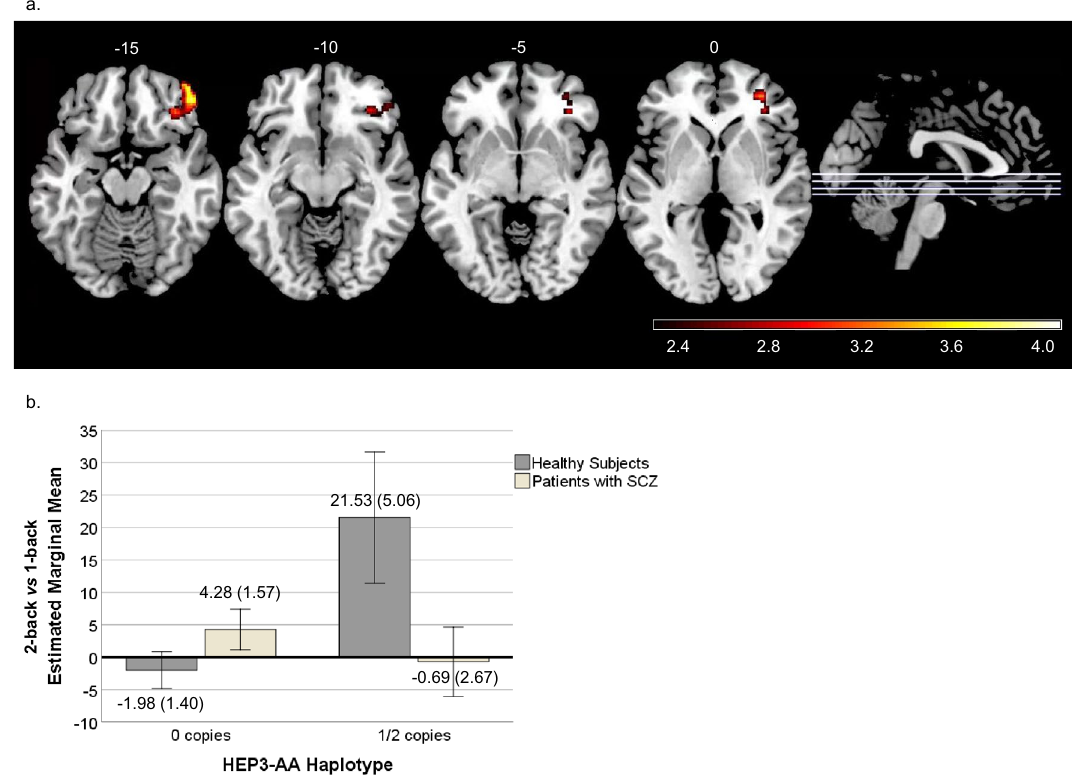
Figure 3. ( a ) Brain regions showing the axial view of the cluster with significant diagnosis × HEP3-AA interaction in 2-back vs 1-back contrast. The right side of the image represents the right side of the brain. The MNI coordinates are given for each slice. Units of the bar are the corresponding β values from the regression standardised to Z-scores. ( b ) Plot corresponding to the estimated marginal mean activity scores ± 2 standard error (SE) for the HEP3-AA haplotype copies in healthy subjects (92.9% with 0 copies and 7.10% with 1 or 2 (1/2) copies) and patients with SZ (74.30% with 0 copies and 25.70% with 1 or 2 (1/2)